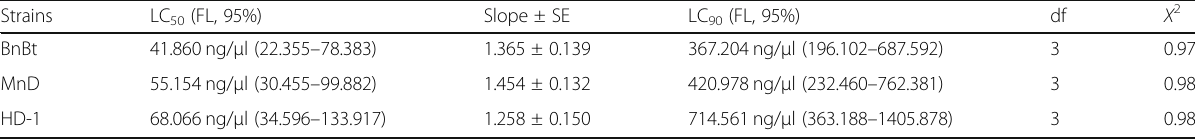
Table 1 LC 50 and LC 90 values of Vip3 proteins of BnBt and MnD against Spodoptera littoralis larvae Strains LC 50 (FL,